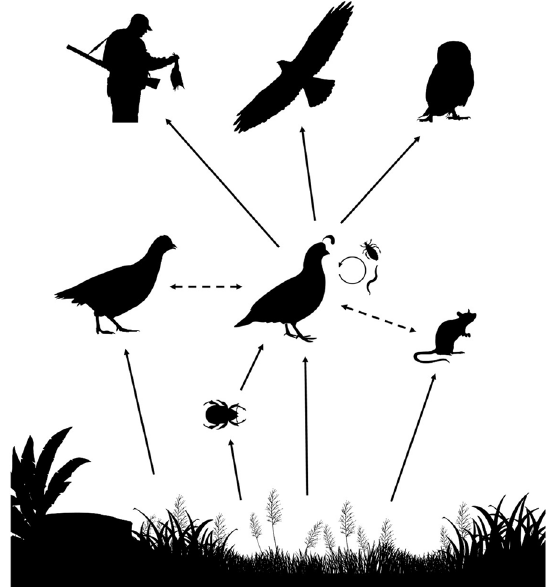
Fig. 2 Idealized food web of California Quail in Chile. Likely links with food plants (leaves, fruits, seeds), potential competitors (tinamous, granivorous/frugivorous rodents), endo and ectoparasites, and predators (hawks and